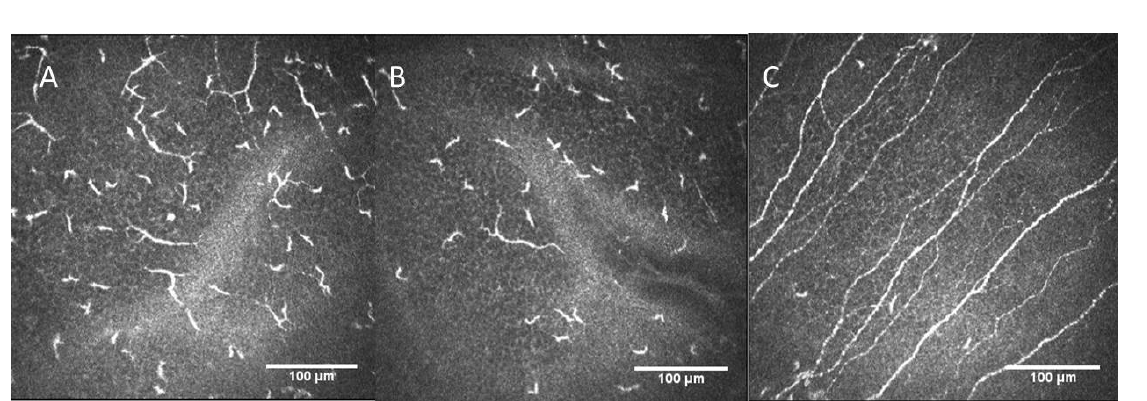
Figure 1. ( A ) Corneal nerve plexus in affected patient RE; ( B ) corneal nerve plexus in affected pa- tient LE; ( C ) corneal nerve plexus image in a patient without systemic pathologies and no refractive surgery (control group). RE: right eye; LE: left eye.